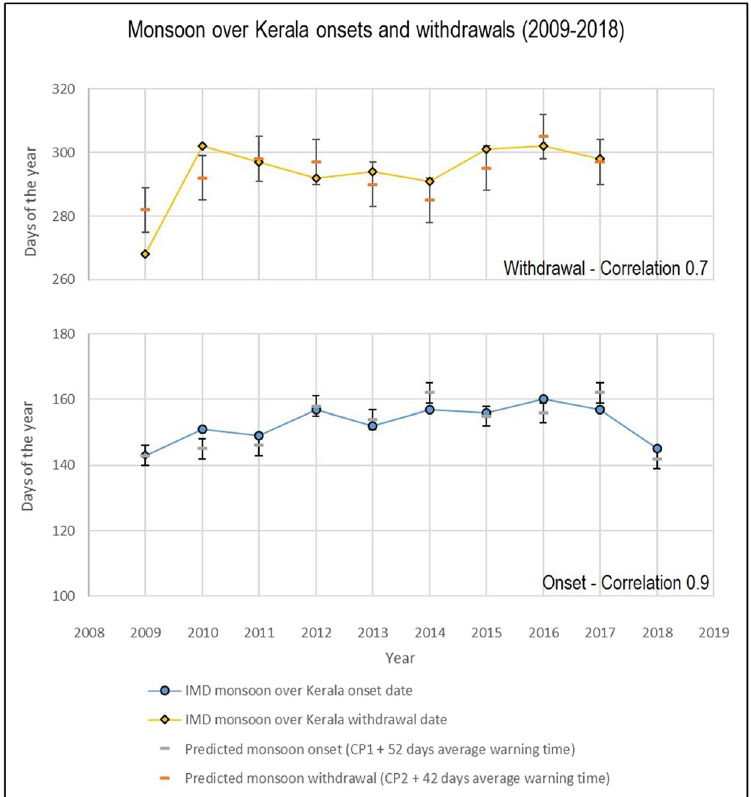
Figure 3. Forecast for 2009–2018 monsoon onset over Kerala using transequatorial approach. Onset prediction is based on a lead time of 52 ± 3.7 days; withdrawal prediction on a lead time of 42 ± 7.3 days. Correlation between IMD monsoon onset and predicted onset using transequatorial method (CP1 + averaged lead time) is 0.89. Correlation between IMD monsoon withdrawal and predicted withdrawal using transequatorial method (CP2 + averaged lead time) is